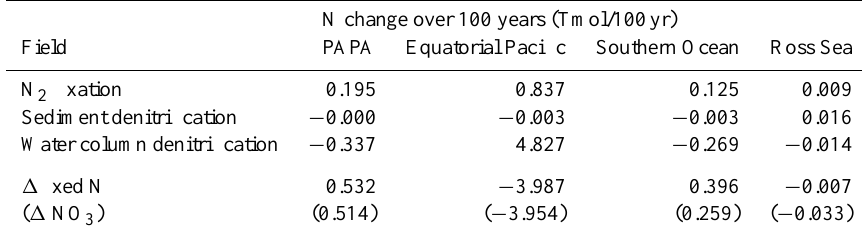
Fig. 7. Perturbation maps of the 1200x iron fertilization scenarios at year 100. The first column, (a–d) , shows the nitrate concentration perturbation inmmolm − 2 integrated vertically from 98m depth to the bottom; the second column, (e–h) , is the oxygen concentration perturbation in mol m − 2 integrated vertically from 98m depth to the bottom; and the third column, (i–l) , is cumulative export production across 98m integrated over the 100 years of the simulation in mmolm − 2 . The first row of results is for PAPA, the second for the equatorial Pacific, the third for the Southern Ocean and the bottom row is the Ross Sea. Table 4. Global perturbation nitrogen budget for each of the iron fertilization scenarios in the 1200x